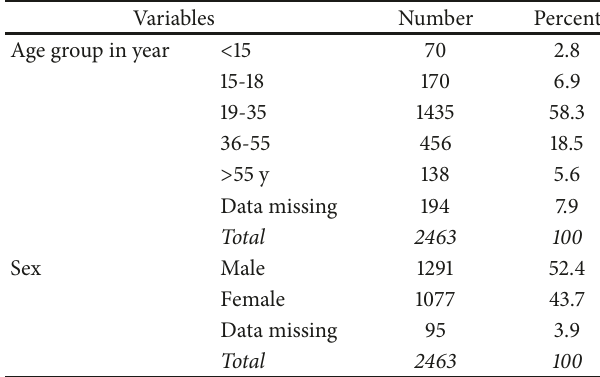
Table 1: Socio demographic characteristics of Smears positive PTB diagnostic dropout rate at public health facilities in Addis Ababa, Ethiopia, from 2011-2016.